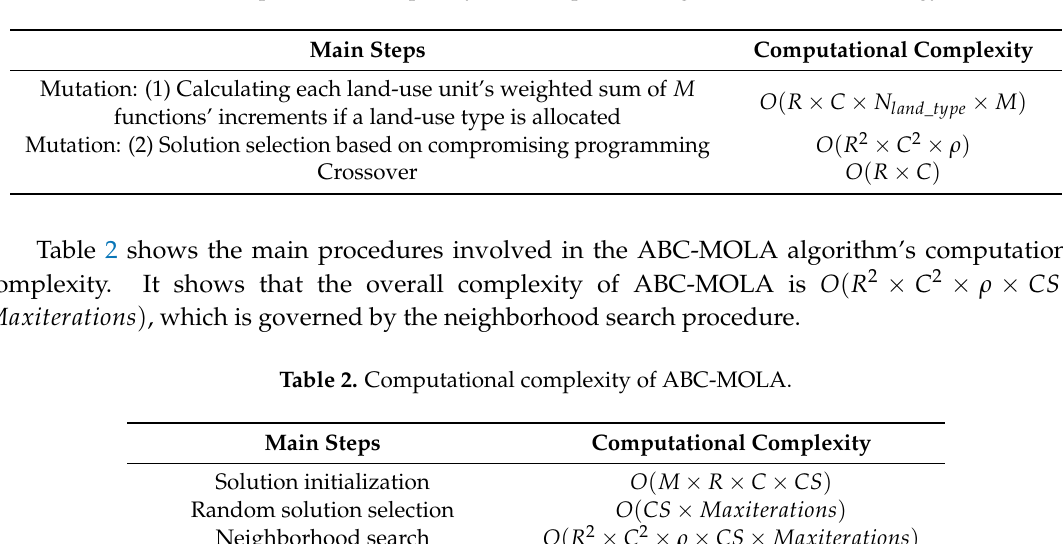
Table 1. Computational complexity of the improved neighborhood search strategy.